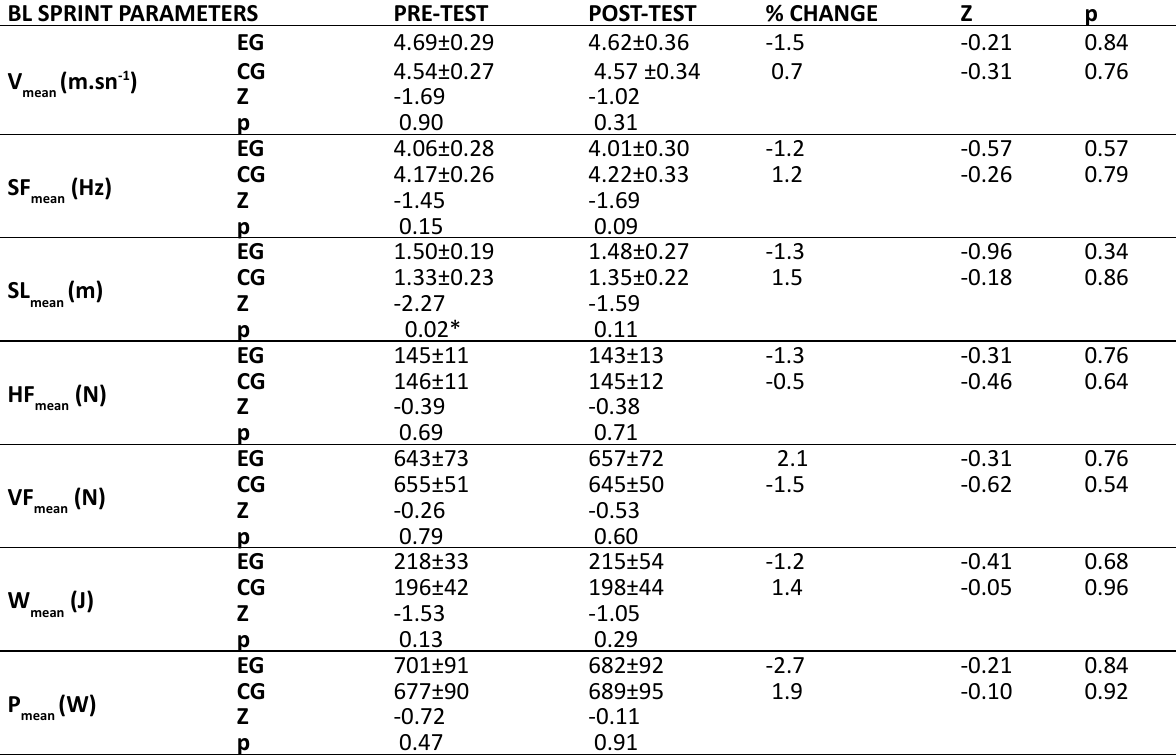
Table 3. Pre- and post-test results of 30m BL sprint parameters BL SPRINT